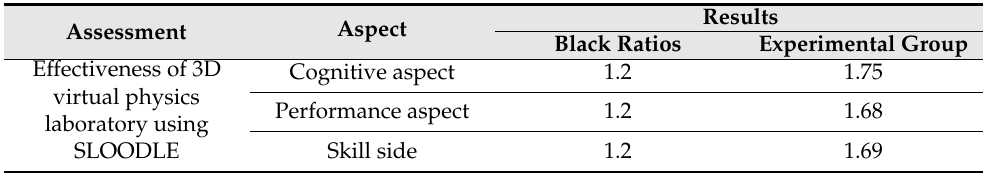
Table 12. Summarized achieved results of the effectiveness of 3D virtual physics laboratory using